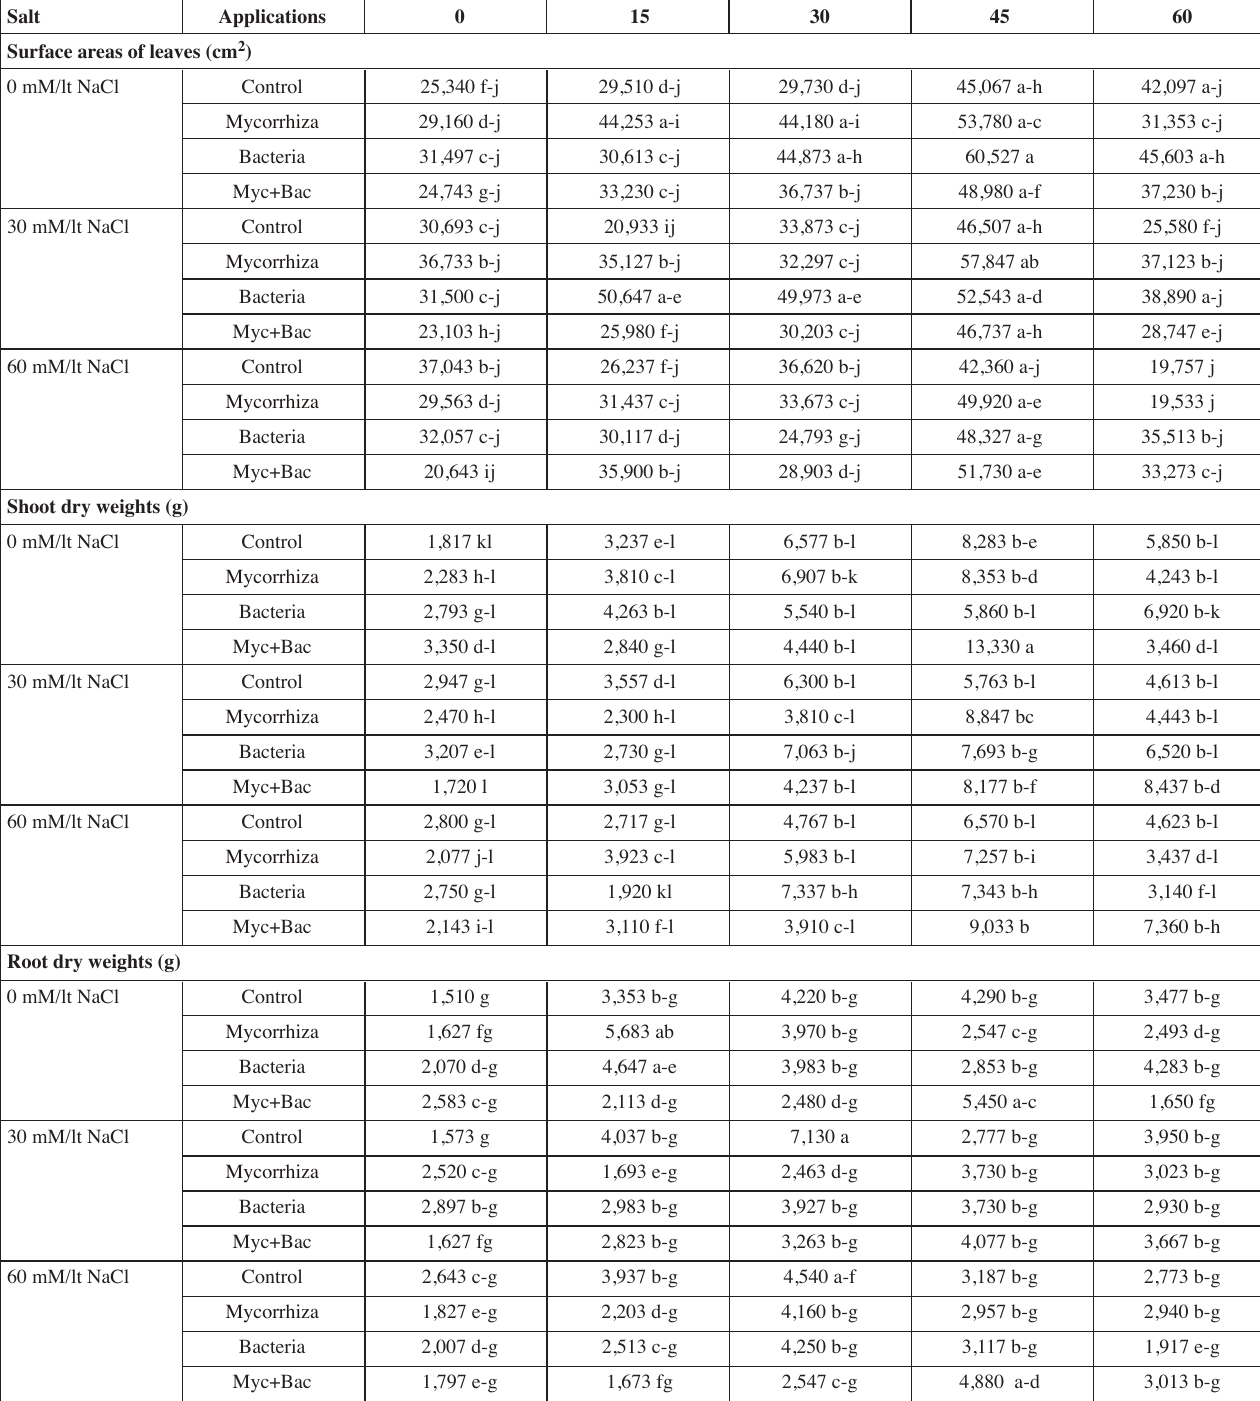
Tab. 3: Surface areas of leaves, shoot and root dry weights in the leaf tissues of strawberry ‘San Andreas’ plants under salt (0, 30 and 60 mM/L NaCl) stress and applications (control, mycorrhiza, bacteria and myc+bac) for the periods of 0, 15, 30, 45 and 60 days. Salt Surface areas of leaves (cm 2